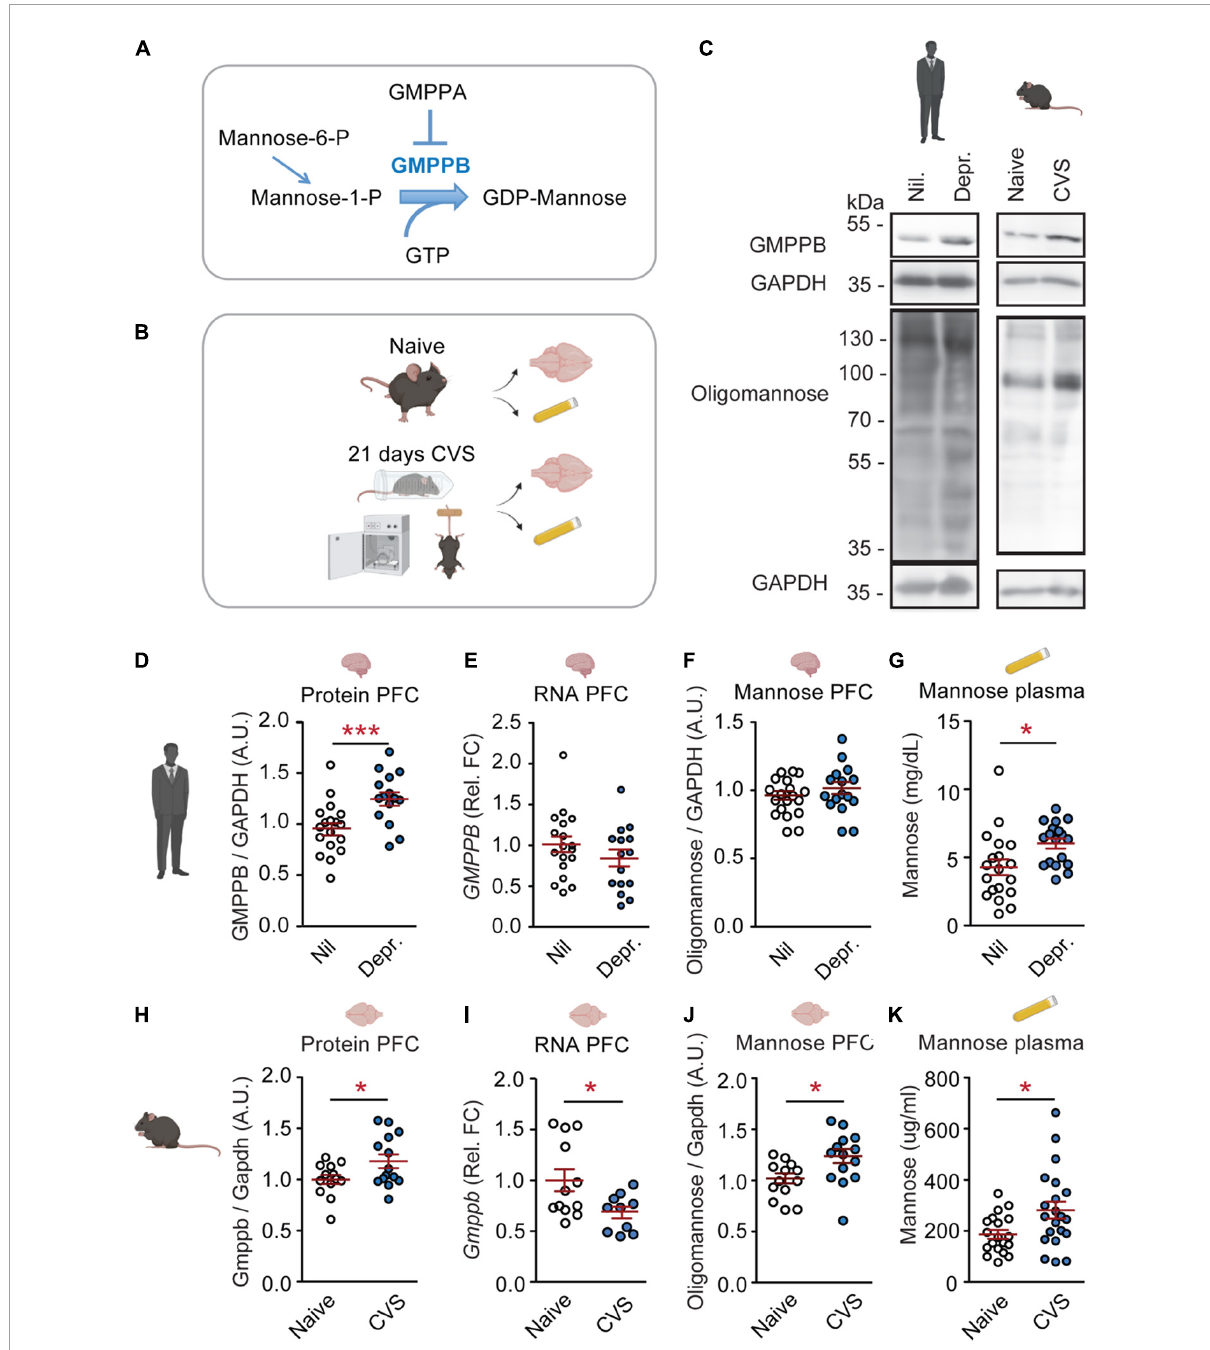
FIGURE1 GMPPB and plasma mannose are increased by chronic stress and depression. (A) Cartoon illustrating the regulation of GDP-mannose production. (B) Experimental setup for CVS-experiment. (C) Representative western blots. (D–K) Statistics: Student’s t -test. (D–G) Results from human cohorts. (D–F,H–J) Prefrontal cortex. (G,K) Plasma. (D) Increased GMPPB protein-levels in depressed patients (Depr.) vs. controls (Nil); n = 15–18 per group; t 31 = 3.32, ** P < 0.01. (E) No association between depression and GMPPB RNA-levels; n = 15–18 per group; t 31 = 1.22, P = 0.23. (F) No association between depression and oligomannose-levels. n = 15–19 per group; t 32 = 0.59, P = 0.56. (G) Increased plasma mannose in depressed patients; n = 18–19 per group; t 35 = 2.51, * P < 0.05. (H–K) Results from the CVS mouse-model. (H) Increased GMPPB protein-levels in stressed mice; n = 13–14 per group; t 25 = 2.18, * P < 0.05. (I) Reduced Gmppb -RNA levels in CVS-group; n = 10–12 per group; t 20 = 2.13, * P < 0.05. (J) Increased oligomannose-levels in stressed mice; n = 13–14 per group; t 25 = 2.53, * P < 0.05. (K) Increased plasma mannose in CVS-group. n = 19–21 per group; t 38 = 2.44, * P < 0.05. (D–K) Individual data points are plotted and means ± s.e.m. are shown. A.U., Arbitrary units; Rel. FC, Relative fold change. Illustrations were generated with